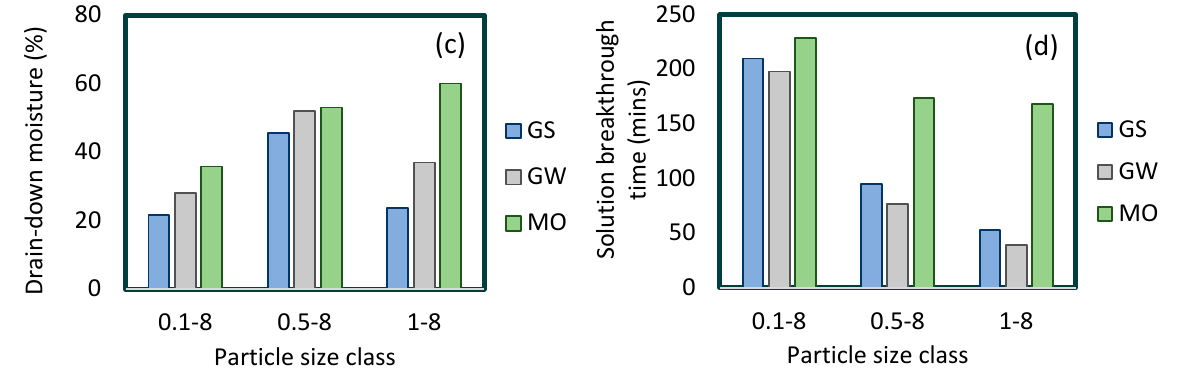
Figure 10. ( a ) Bed voidage, ( b ) total liquid hold-up, ( c ) 24-h drain-down moisture as percentage of total liquid hold-up, and ( d ) solution breakthrough time characterisation data for beds composed of different size fractions of GSs, GW, and MO. Key: 0.1-8 (0.1–8 mm), 0.5-8 (0.5–8 mm), and 1-8 (1–8 mm).